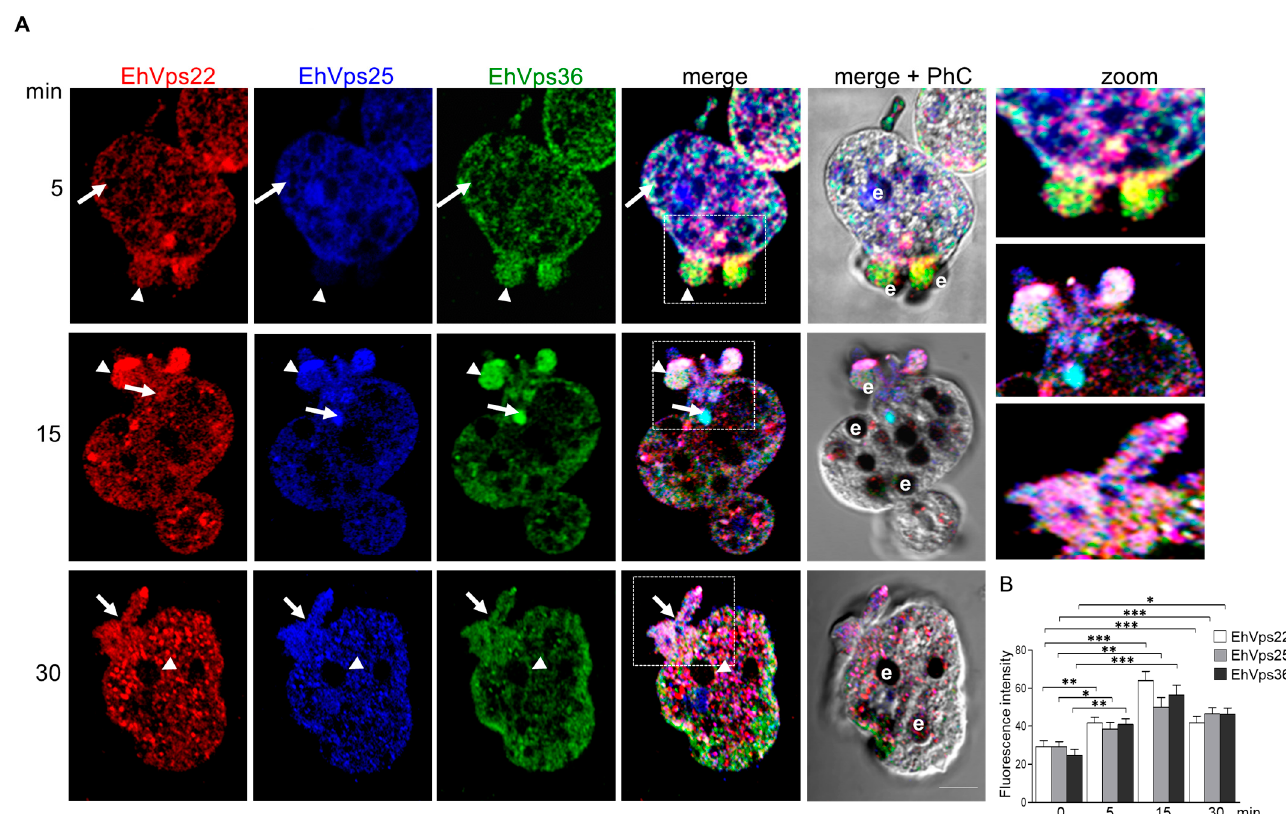
Figure 5. Cellular localization of the ESCRT-II proteins during phagocytosis. ( A ) Trophozoites in basal condition treated with α -EhVps22 (red), α -EhVps25 (blue), and α -EhVps36 (green) antibodies. Arrows indicate the co-localization sites of the three proteins. Arrowheads indicate the co-localization sites on or surrounding the erythrocytes. e: erythrocyte. Bar = 10 µm. Zoom: magnification of the regions marked with white squares in the zoom areas. PhC: phase contrast images. ( B ) Fluorescence intensity was measured by pixels in 30 cells in basal condition and after phagocytosis. (*) p < 0.05, (**) p < 0.01 (***) p < 0.001.